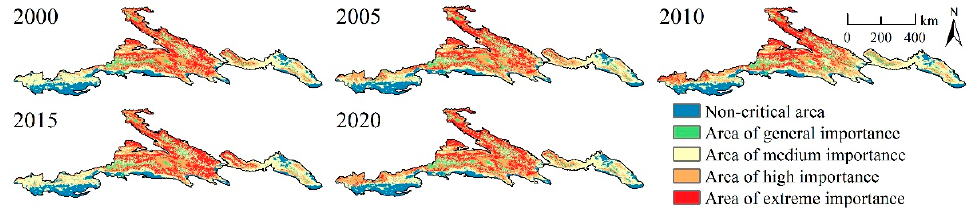
Figure 6. Hotspots of multiple Ess from 2000 to 2020.